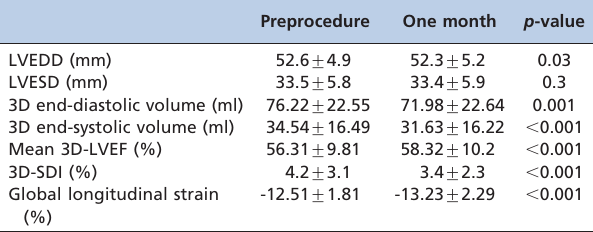
Table 2 - Echocardiographic measures of the successfully revascularized patients before and one month after the procedure (n= 118).